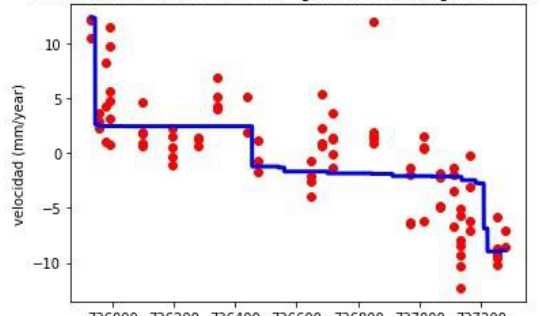
Figure 9 . Training values and the generated model, Random Forest